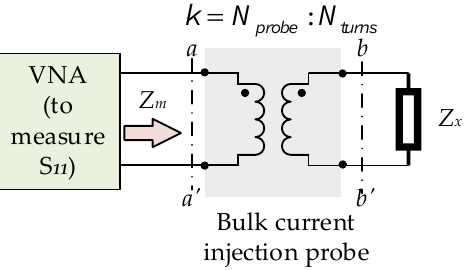
Figure 2. Equivalent circuit involving an ideal transformer to model the BCI probe.